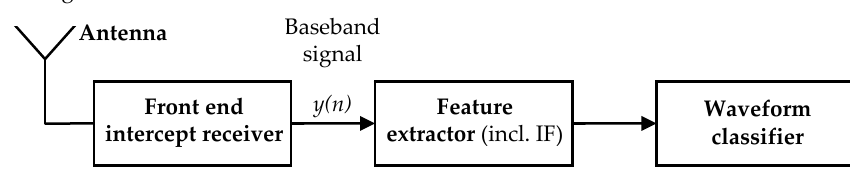
Figure 1. Block diagram of the typical radar waveform recognition system.